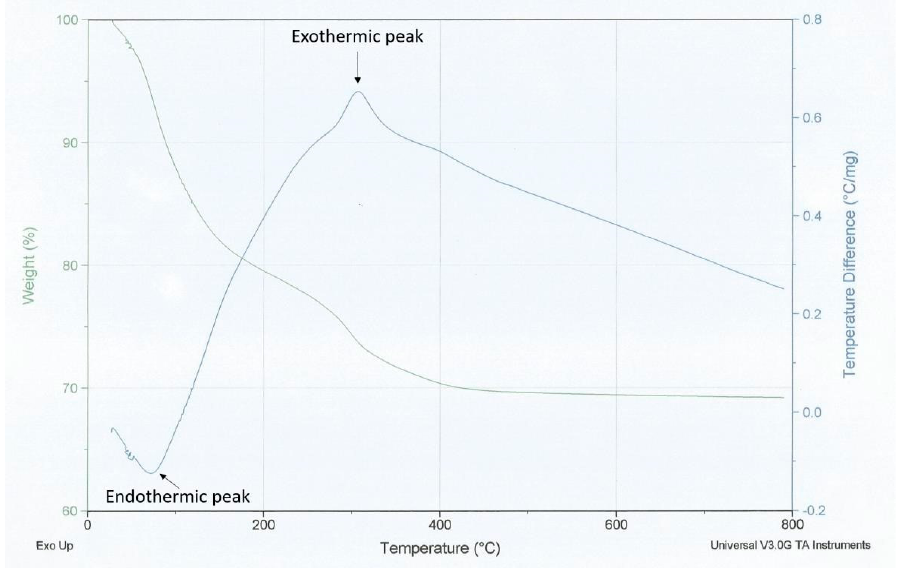
Figure 7. TGA-DTA analysis of the TiO 2 scaffolds.